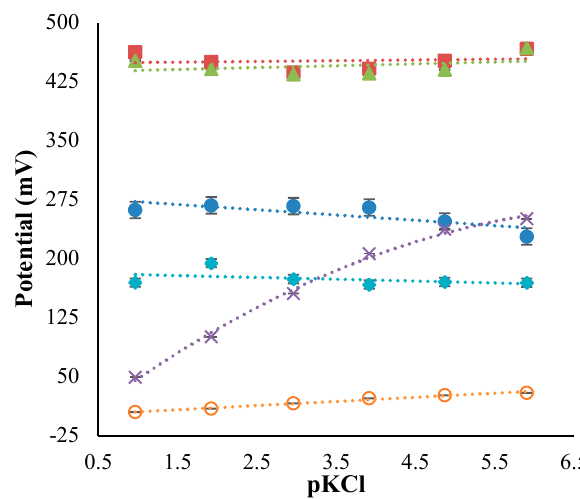
Figure 2. pH ( top ) and KCl ( bottom ) sensitivity of manufactured electrodes; 500 nm RuO 2 (Blue Dots), RuO 2 -SiO 2 (Red Squares), RuO 2 -SiO 2 -KCl (Green Triangles), Glued-RuO 2 (Aqua Diamonds), Quasi-AgCl (Purple Crosses), and AgCl-KCl (Orange Circles).